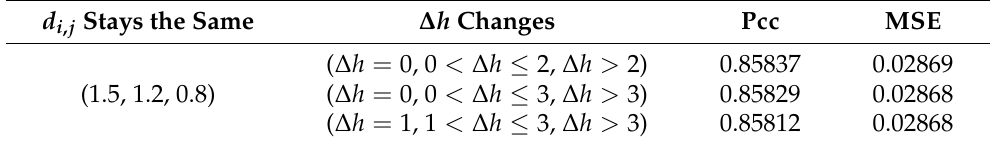
Table 8. Influence of parameters p h and ∆ h on sentence semantics of STS-benchmark with